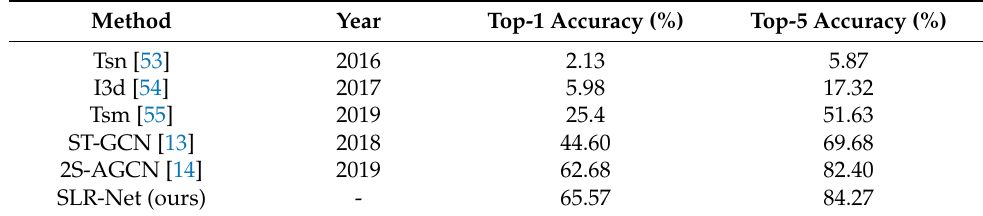
Table 12. The accuracy comparisons with state-of-the-art methods on the DEVISIGN-L